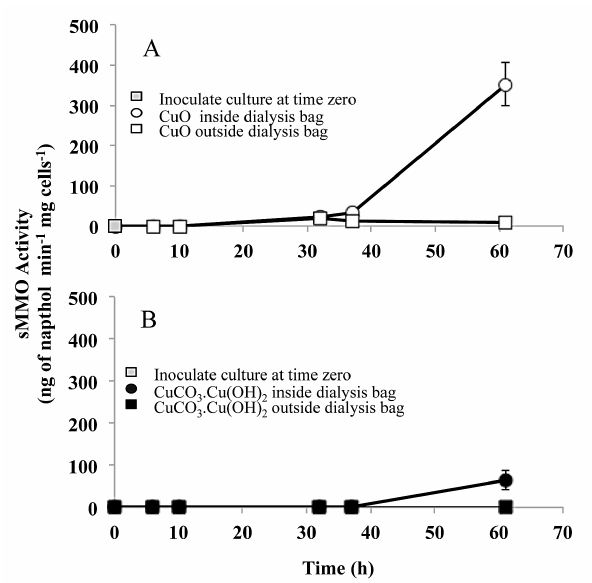
Fig. 3. Affect of direct mineral contact on the formation of sMMO activity (ng of napthol min − 1 mgcelldryweight − 1 ) when the ini- tial culture does not have sMMO activity. sMMO activity presented over time as function of location of the two minerals, (A) CuO and (B) CuCO 3 .Cu(OH) 2 ; i.e. inside and outside of < 1000Da sieve size dialysis bags. sMMO activity is initially not present, but sMMO ac- tivity appears as cell density increases, especially for CuO without direct cell-mineral contact. Mean specific growth rates for the cul- tures range from 0.45 to 0.50h − 1 . Error bars represent standard deviations ( n =